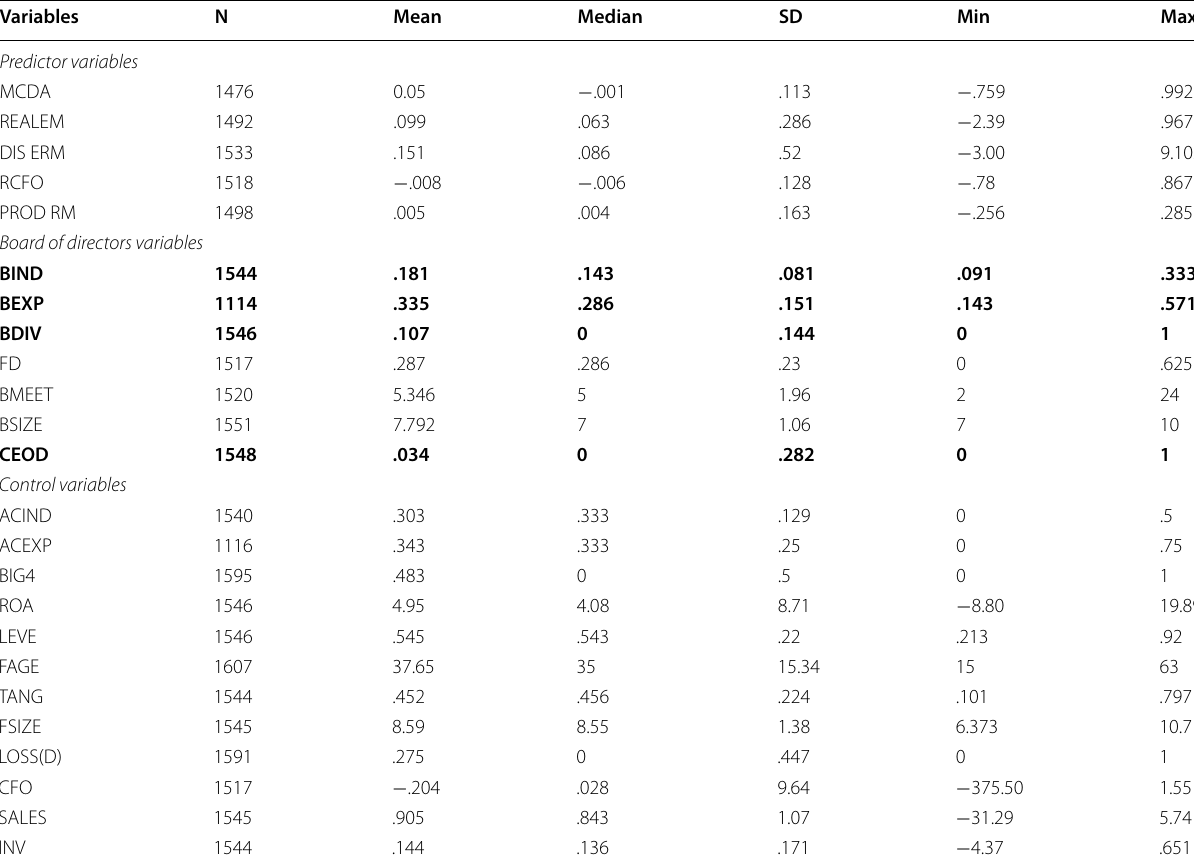
Table 5 Full-sample descriptive